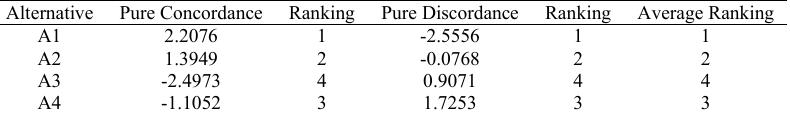
TABLE 13 R ANKING R ESULTS B ASED ON P URE C ONCORDANCE AND P URE D